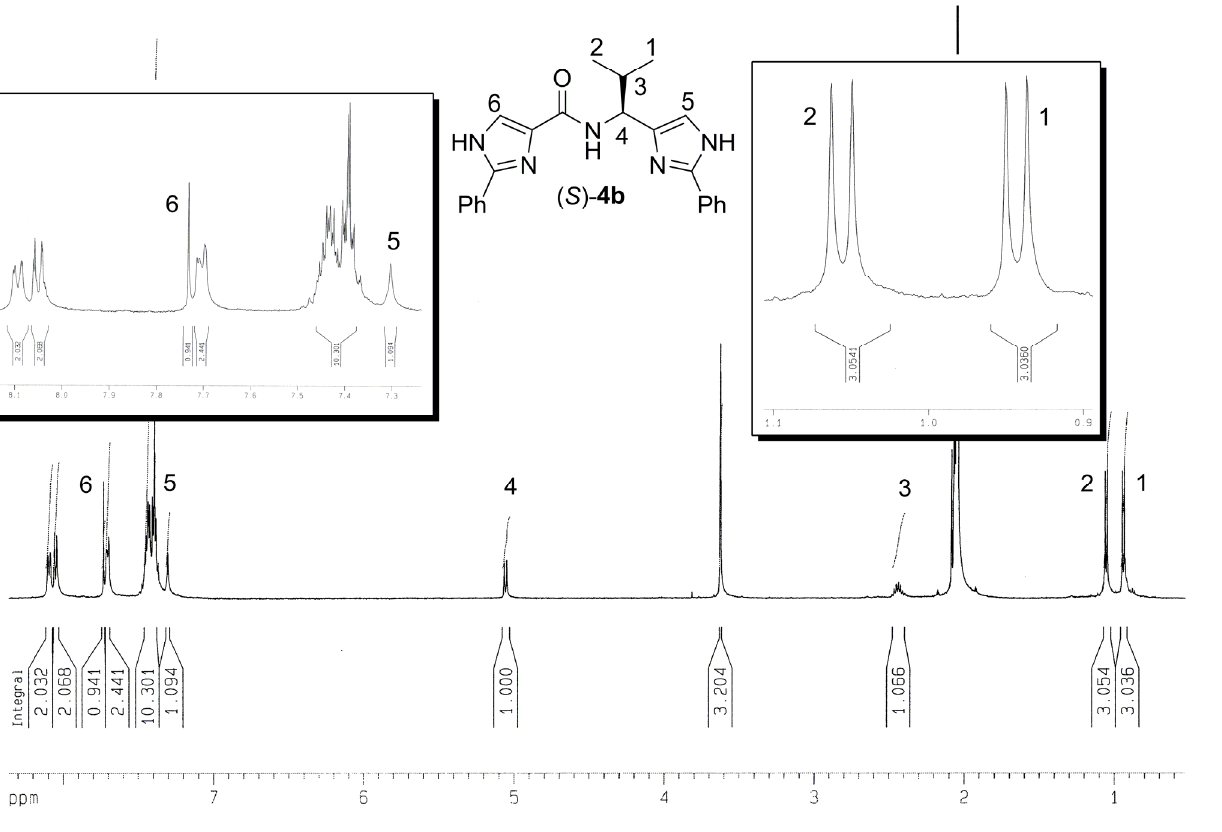
Figure 1. 1 H-NMR spectra of ( S )- 4b measured with ( R )-Mosher’s acid ( d for the ee’s